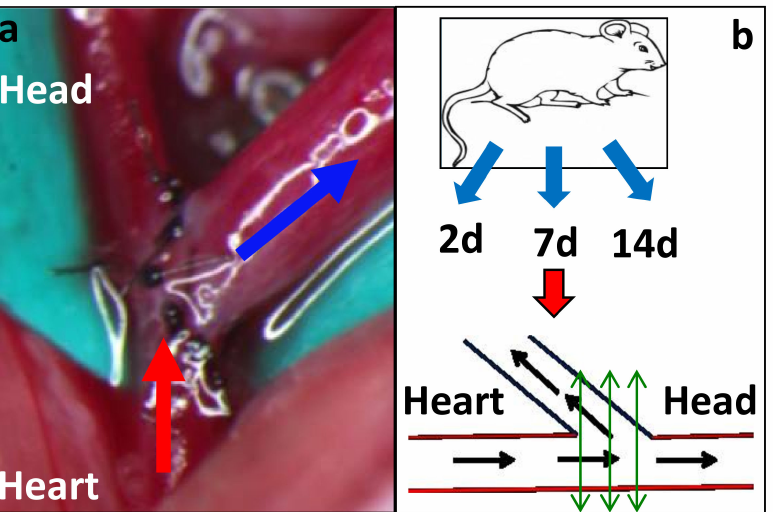
Figure 5. Mouse AVF surgery and histology techniques: ( a ) describes the final AVF between the side of the carotid artery (red arrow) and the end of the jugular vein (blue arrow). ( b ) (lower panel) documents the technique that we will use to section the anastomosis. Black arrows indicate direction of blood flow; green double-headed arrows indicate how we sectioned the anastomotic region. Heart and Head labels help to indicate the directionality of flow in both